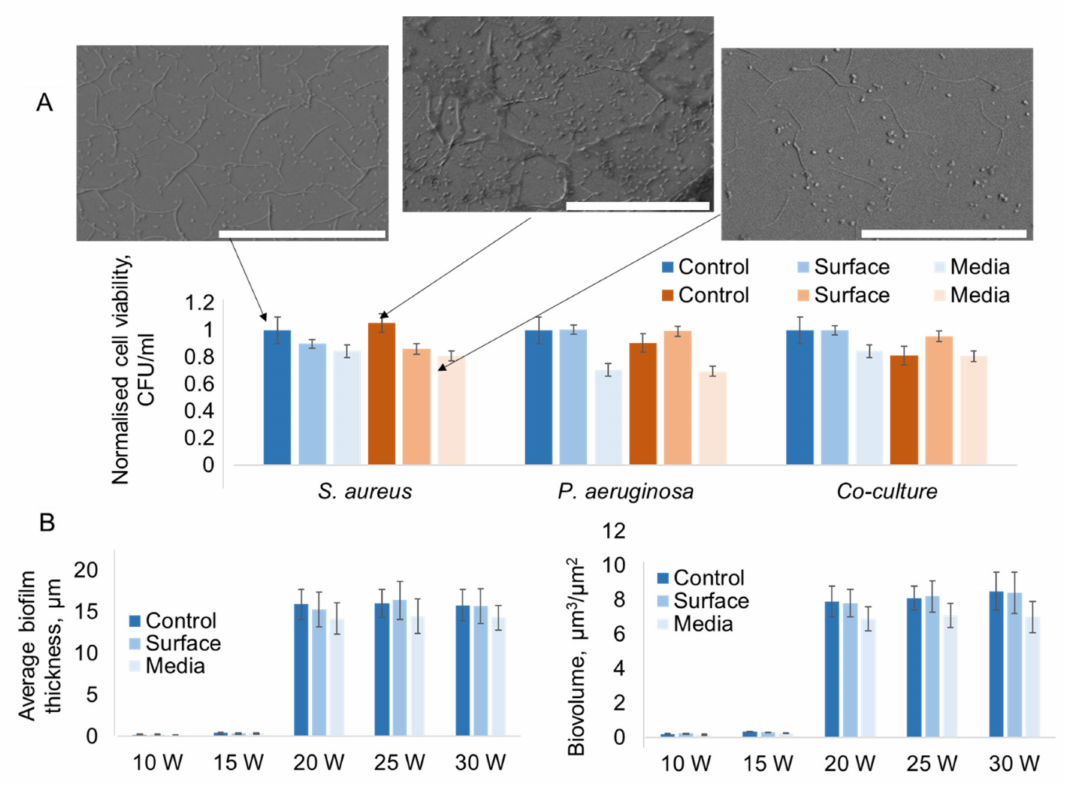
Figure 4. ( A ) Viability of S. aureus , P. aeruginosa bacterial cells and their mix culture when cultured on the surfaces of plasma polymer-modified PET substrata, normalised against colony forming units (CFU) for the “control biofilm” for each culture type. Inset: SEM images of S. aureus attachment after 24 h of incubation, scale bar 50 µ m. Data shown for polymer coatings fabricated at 10 W, incubation time of 24 h. Blue bars: inoculum cells harvested from a mature biofilm (grown on the surface of culture plate for 72 h), red bars: from a planktonic culture. ( B ) Average biofilm thickness and biovolume of P. aeruginosa cells grown for 24 h from for polymer coatings fabricated at different RF